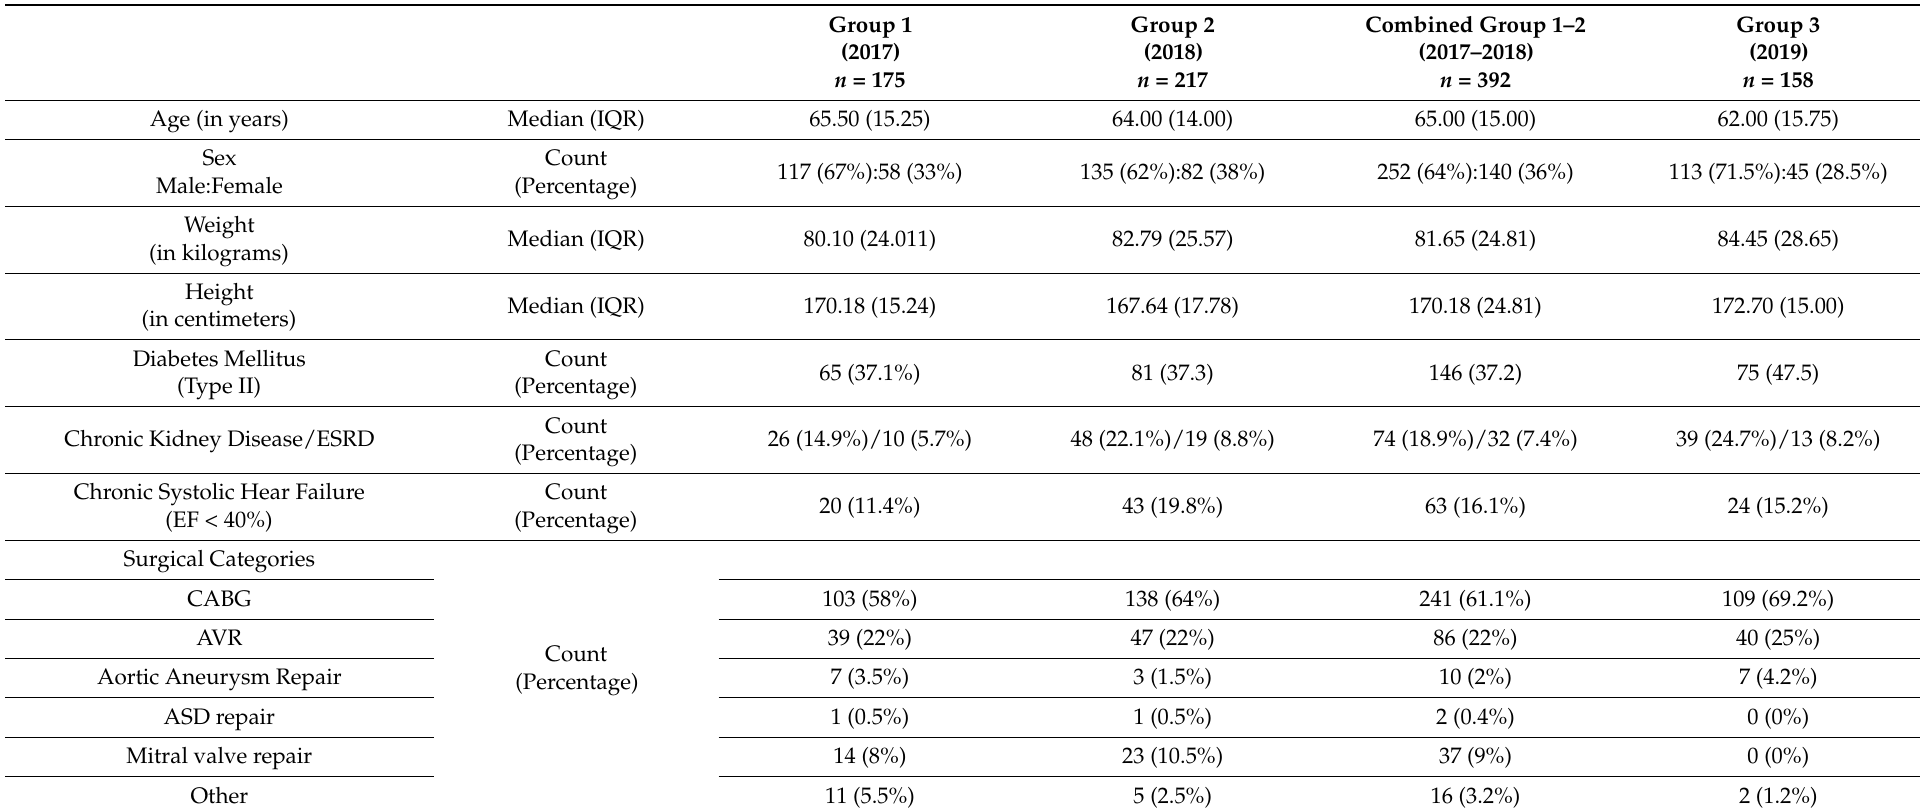
Table 1. Baseline characteristics and demographics of